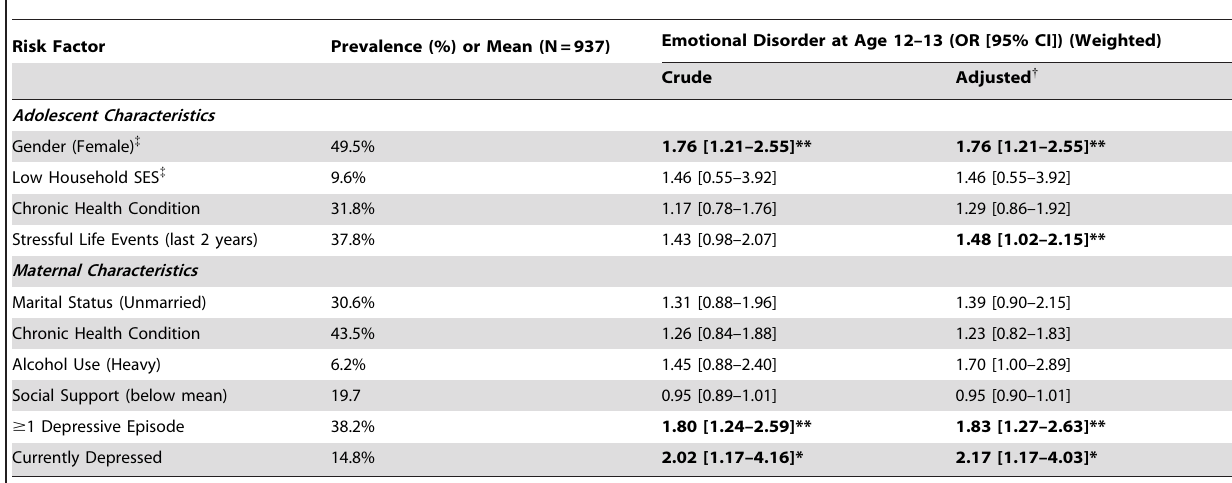
Table 1. Odds Ratios for Adolescent Emotional Disorder Associated with Demographic and Health Factors in Participants Aged 12–13 Years (Bivariate